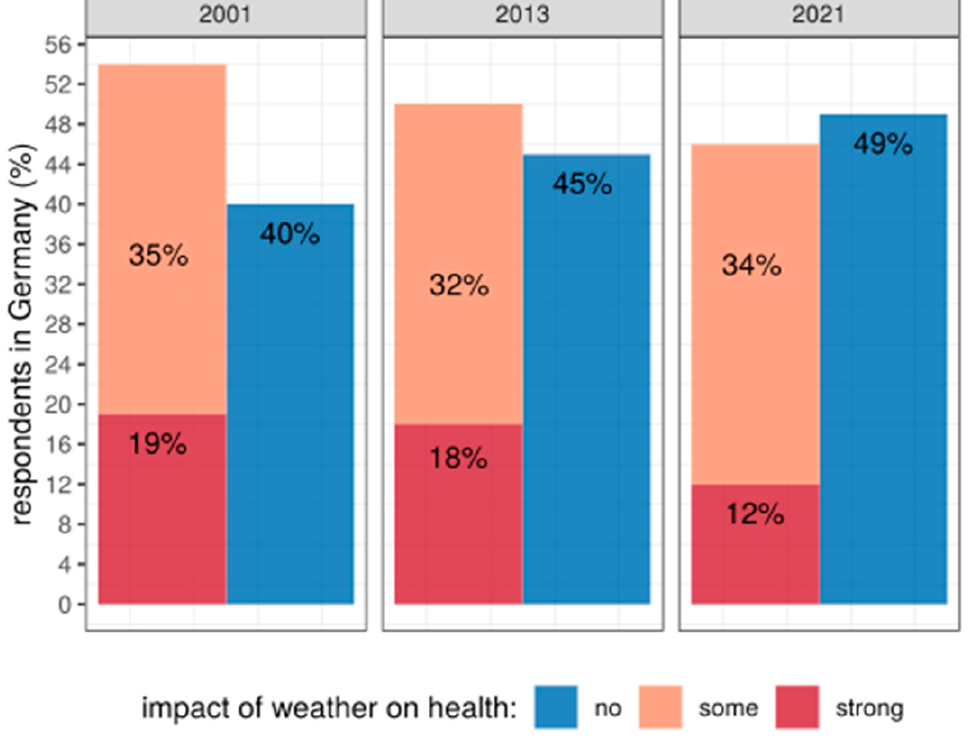
Figure 1. Impact of weather on the health of the German population aged 16 and over. Data are based on representative surveys conducted by IfD Allensbach (self-assessment by respondents).